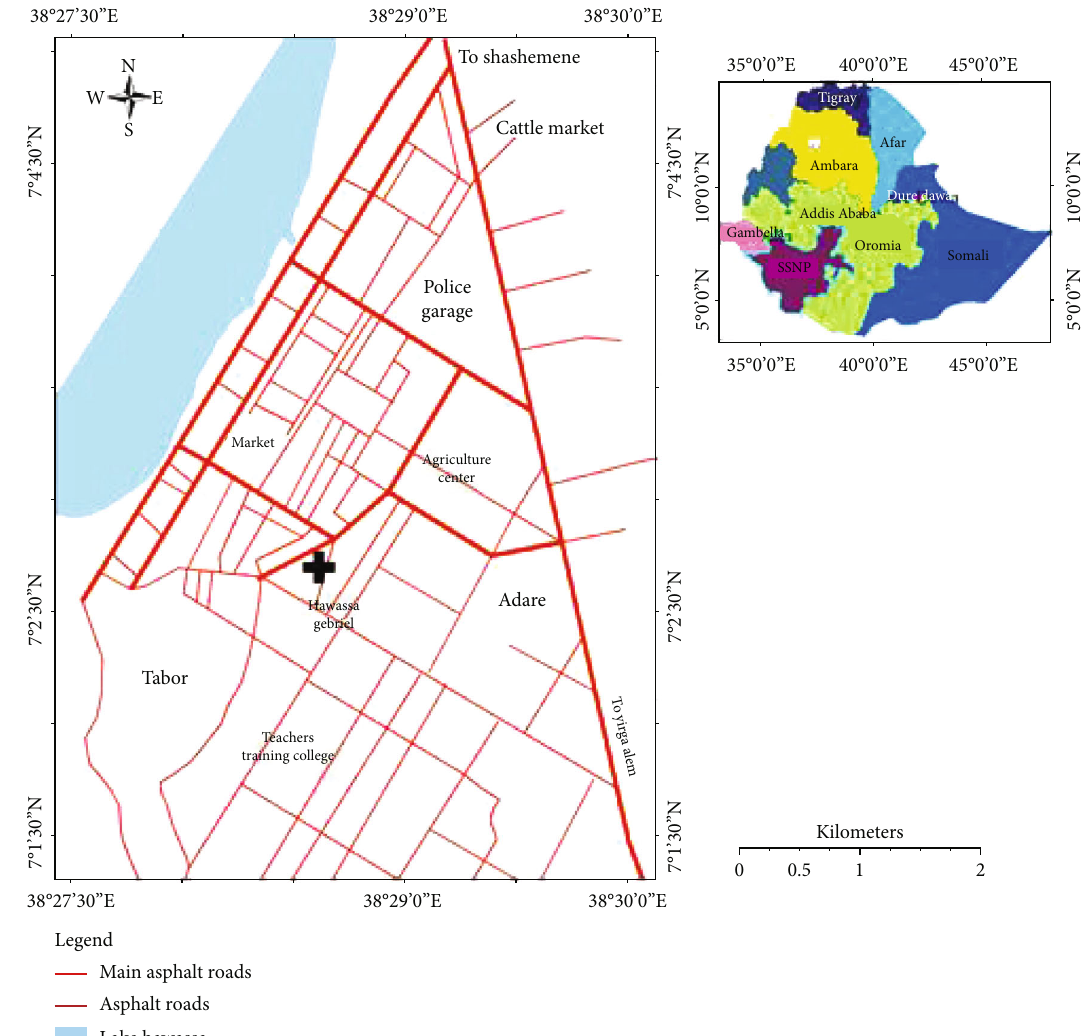
Figure 1: Location map of Hawassa town in Southern